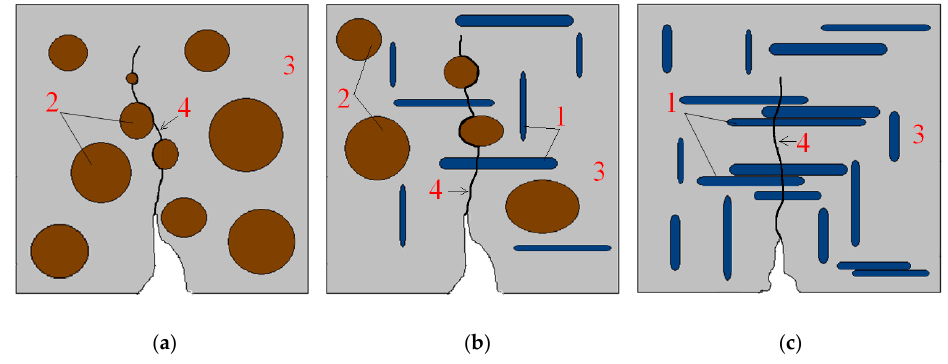
Figure 5. Scheme of Bending Destruction of Polymer Concrete with Different RGA and SGA contents: